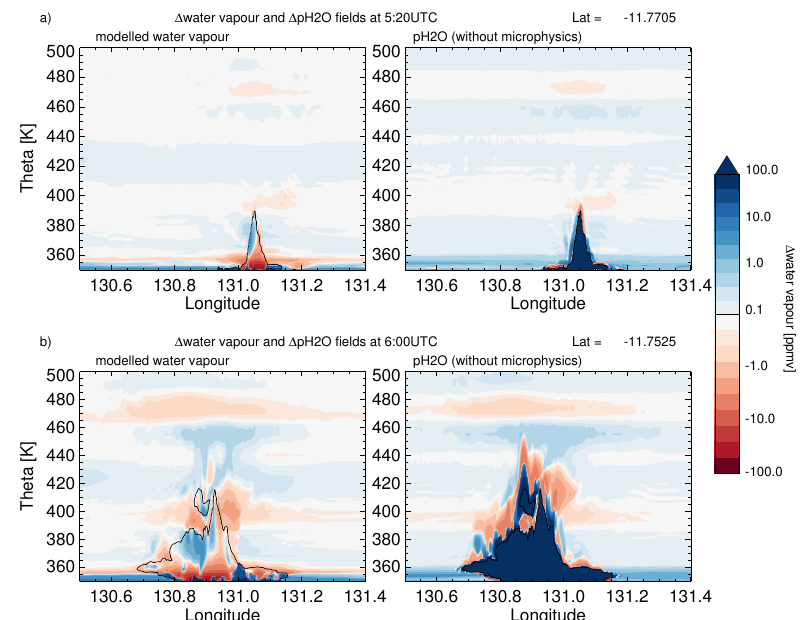
Figure 13. Cross sections of differences in modelled water vapour from the pre-Hector water vapour field (left) and p H 2 O from the initiali- sation profile (right) at 05:20UTC (a) and 06:00UTC (b) .